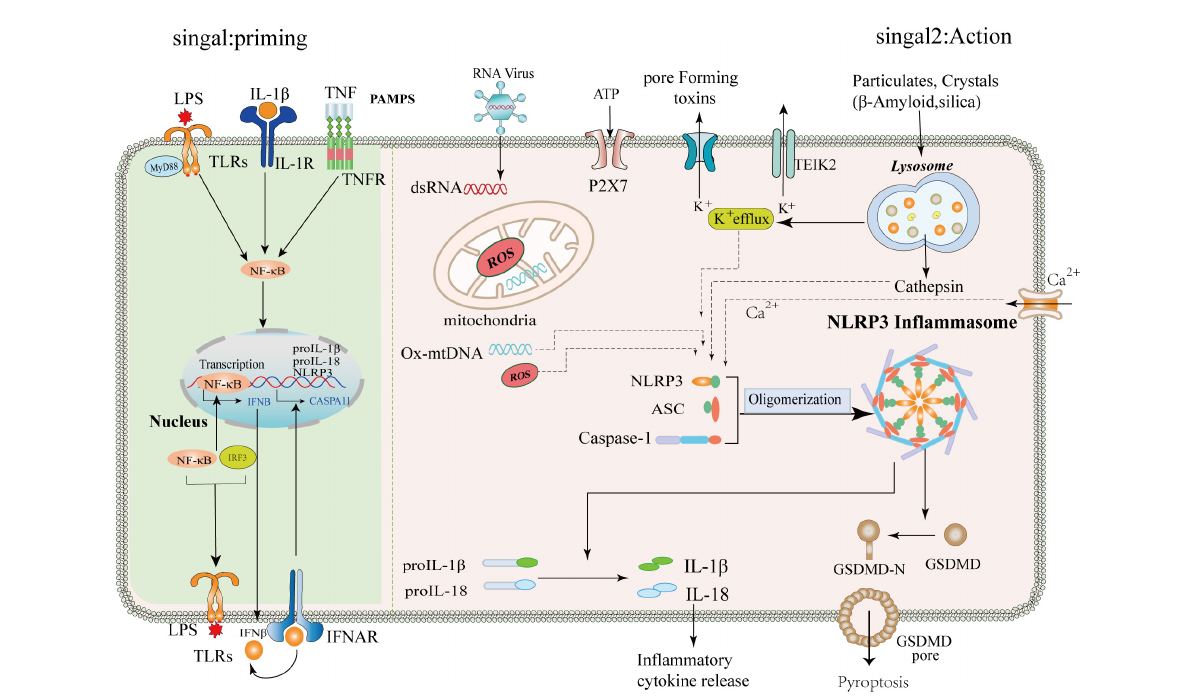
FIGURE2 Mechanism of priming and activation of NLRP3 inflammasome. Priming signal: (Signal 1, left) Cells are exposed to the stimulation of various emergency factors, toll-like receptors (TLRs) and Tumor Necrosis Factor Receptor (TNFR) recognize pathogen-associated molecular patterns (PAMPS) and activate transcription factor NF- κ B. NF- κ B upregulates the expression of NLRP3, ProIL-1 β , and pro-IL18. Activation signals: (Signal 2, right) The NLRP3 inflammasome can be activated by different substances, such as RNA viruses, sterile inflammation, toxic proteins, and environmental stimuli. The upstream signaling of NLRP3 is subsequently activated, which includes potassium ion (k + ) efflux, altered calcium ion flux (Ca 2 + ), mitochondrial dysfunction, and lysosomal disruption releasing cathepsins, among others. The NLRP3 protein, ASC, and pro-caspase-1 assemble into a mature complex, then convert the immature forms of IL-1 β and IL-18 into mature ones. IL-1 β and IL-18 are involved in subsequent inflammation, and IL-1 β /IL-18 can be released into the extracellular space to propagate inflammatory signals to neighboring cells. In addition, NLRP3 activation can promote the cleavage of GSMDM by caspase-1 to form GSMDM-N and induce cell